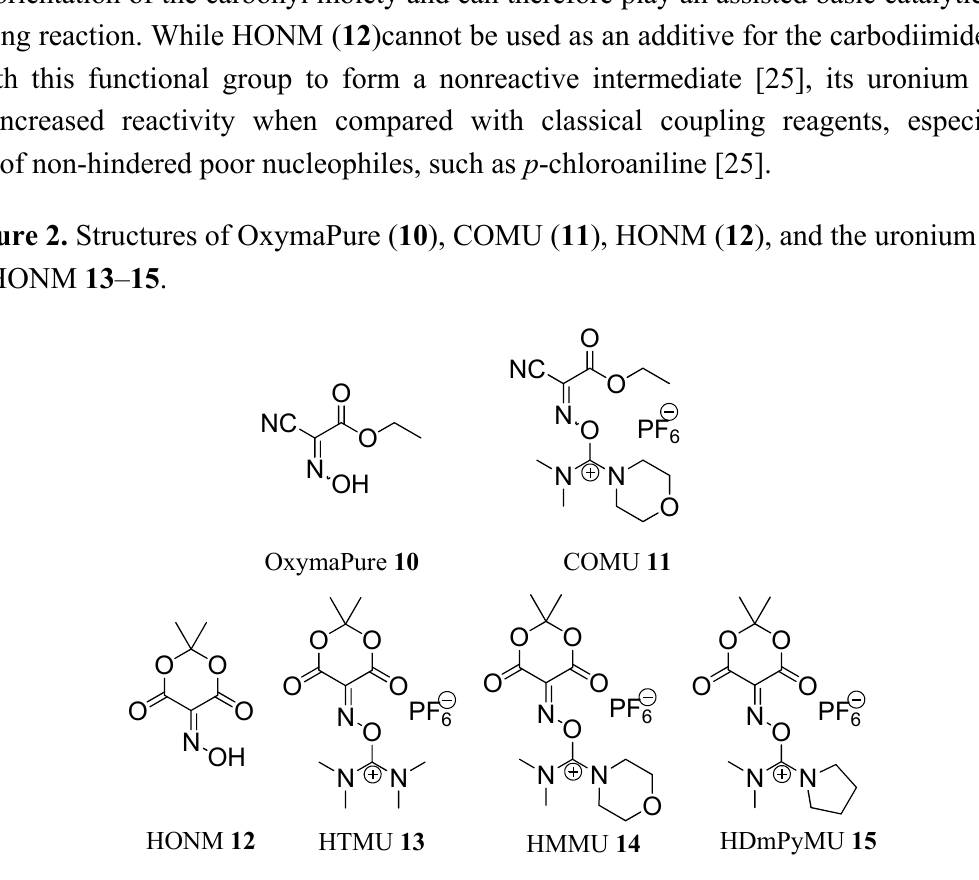
Figure 3. Structures of Oxyma-B ( 16 ) and its uronium